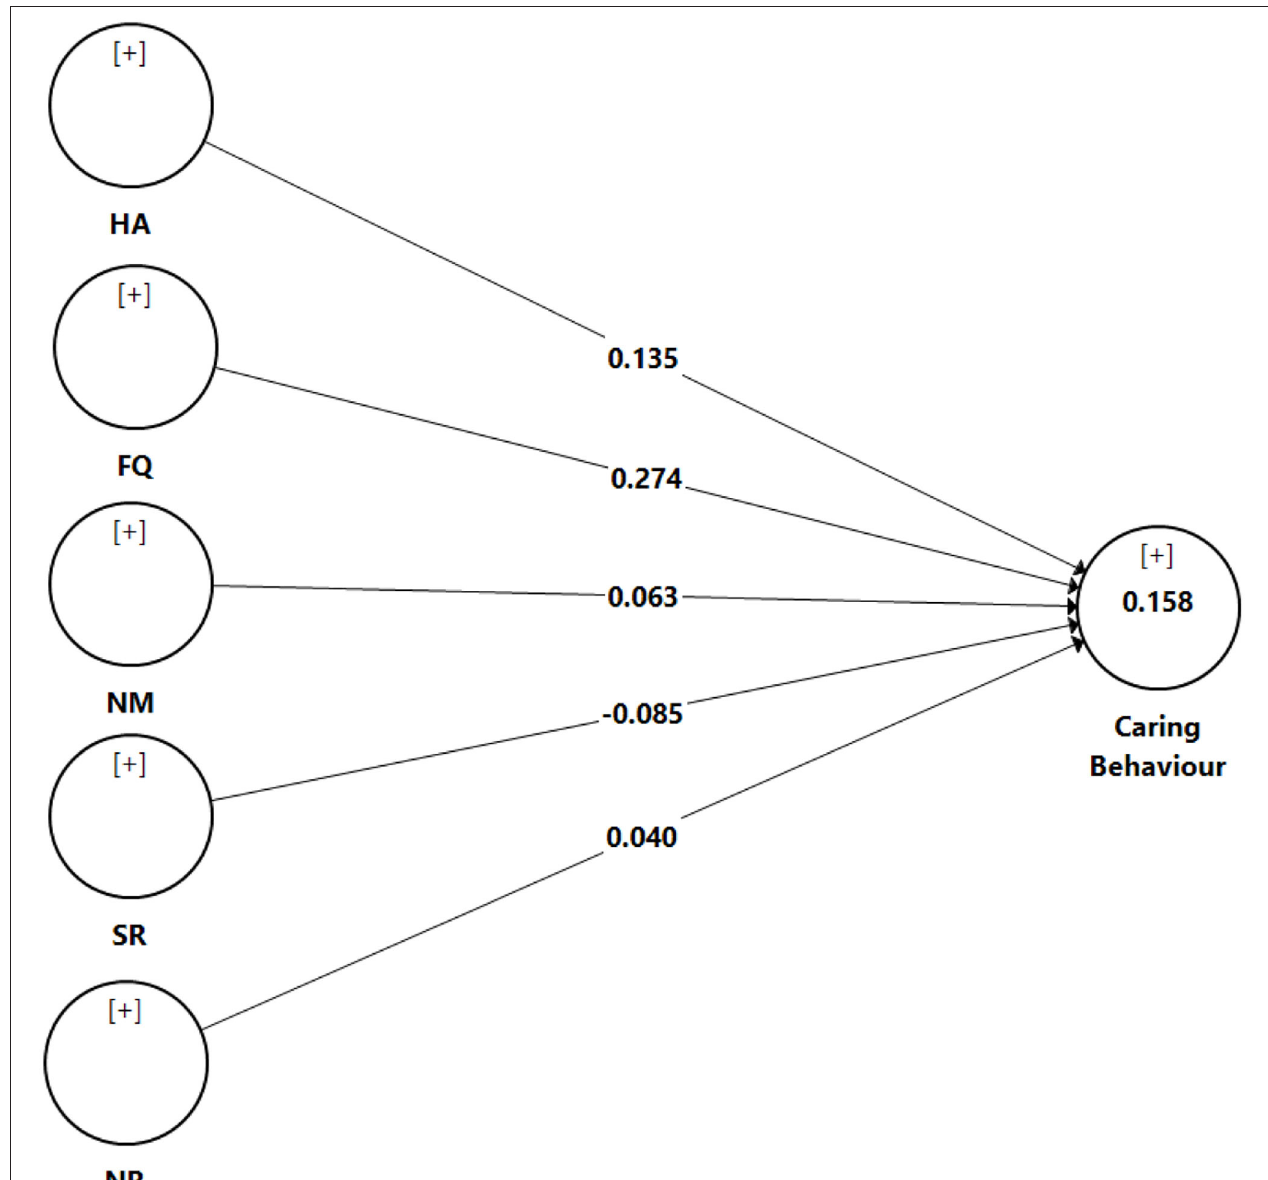
FIGURE 2 | Results: assessment of structural model. NR, nurse–physician relationship; FQ, nursing foundations for quality of care; NM, nursing manager ability, leadership, and support of nurses; HA, nursing participation in hospital affairs; SR, staffing and resource